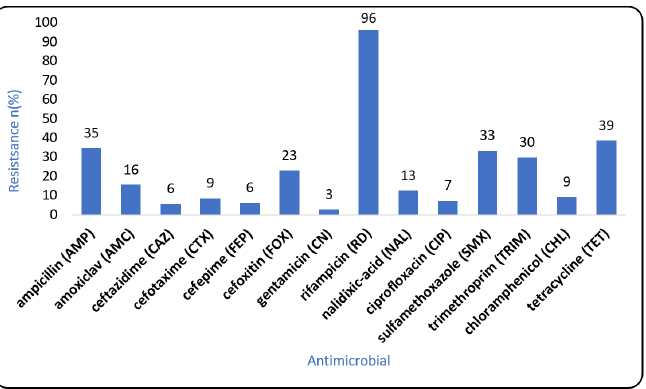
Figure 2. Figure showing the overall antimicrobial resistance profiles. The profiles of resistance were determined by examining 551 bacteria isolates taken from chicken and pork samples, comprising both Gram-positive and Gram-negative organisms. The percentage resistance was calculated by dividing the number of resistant isolates with the total number of test isolates.